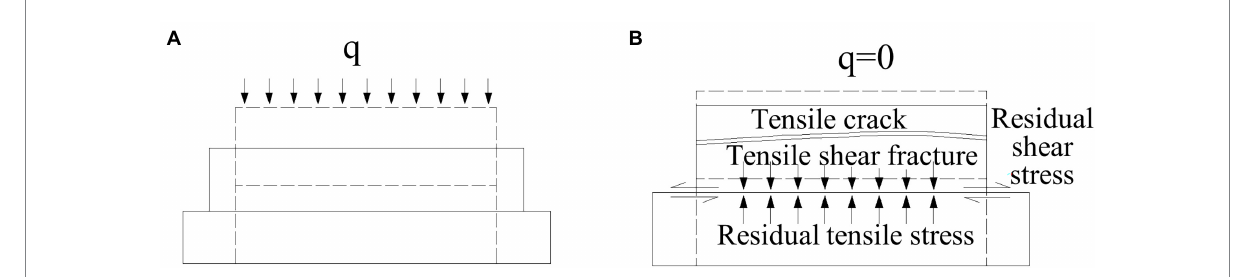
FIGURE 1 Rock mass slabbing of slope under different stress states.